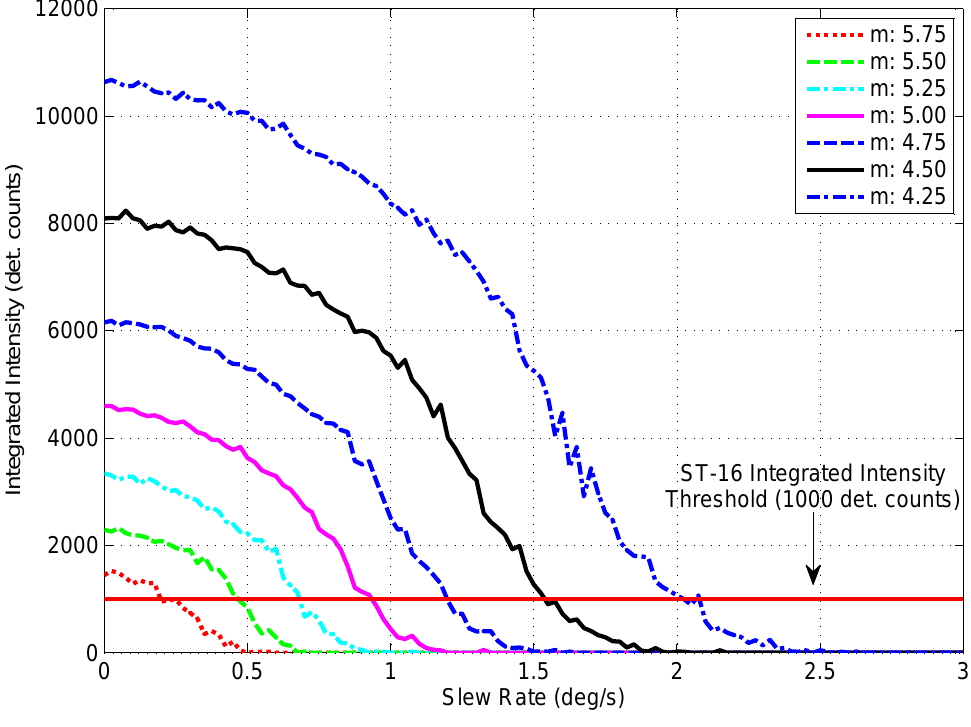
Figure 9. Simulated star intensity at varying slew rates (Reed sensitivity